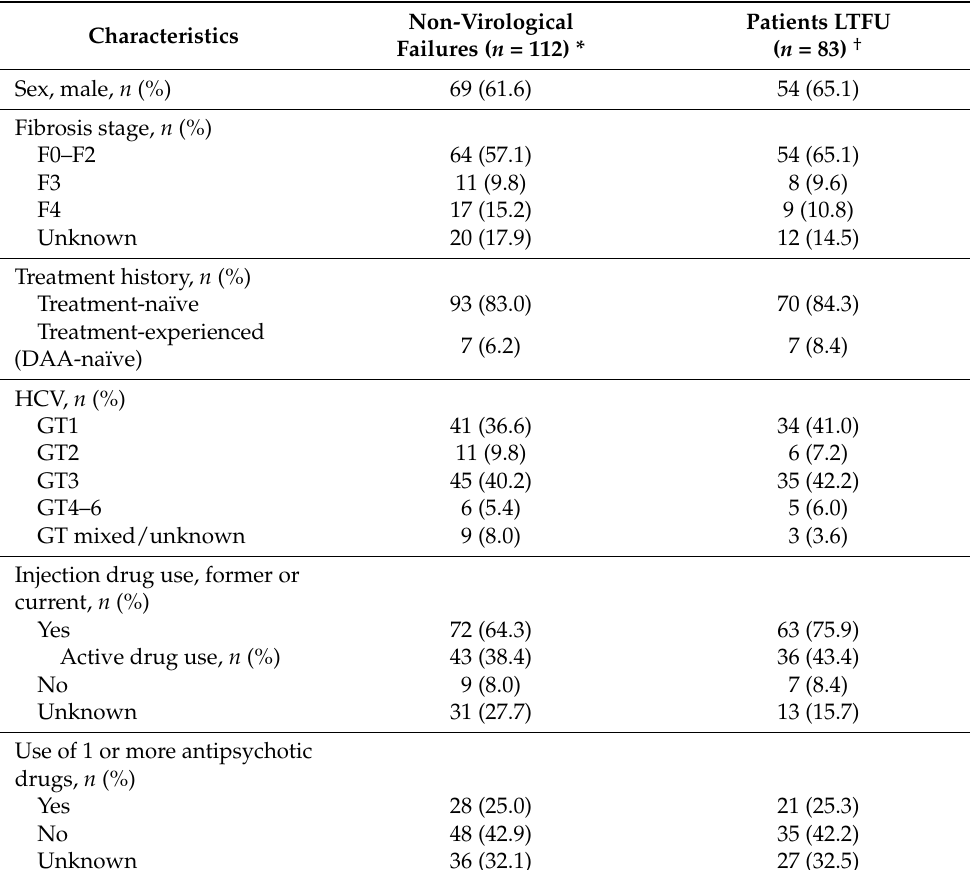
Table 2. Baseline demographic characteristics of patients who did not achieve SVR due to non- virological reasons, including those